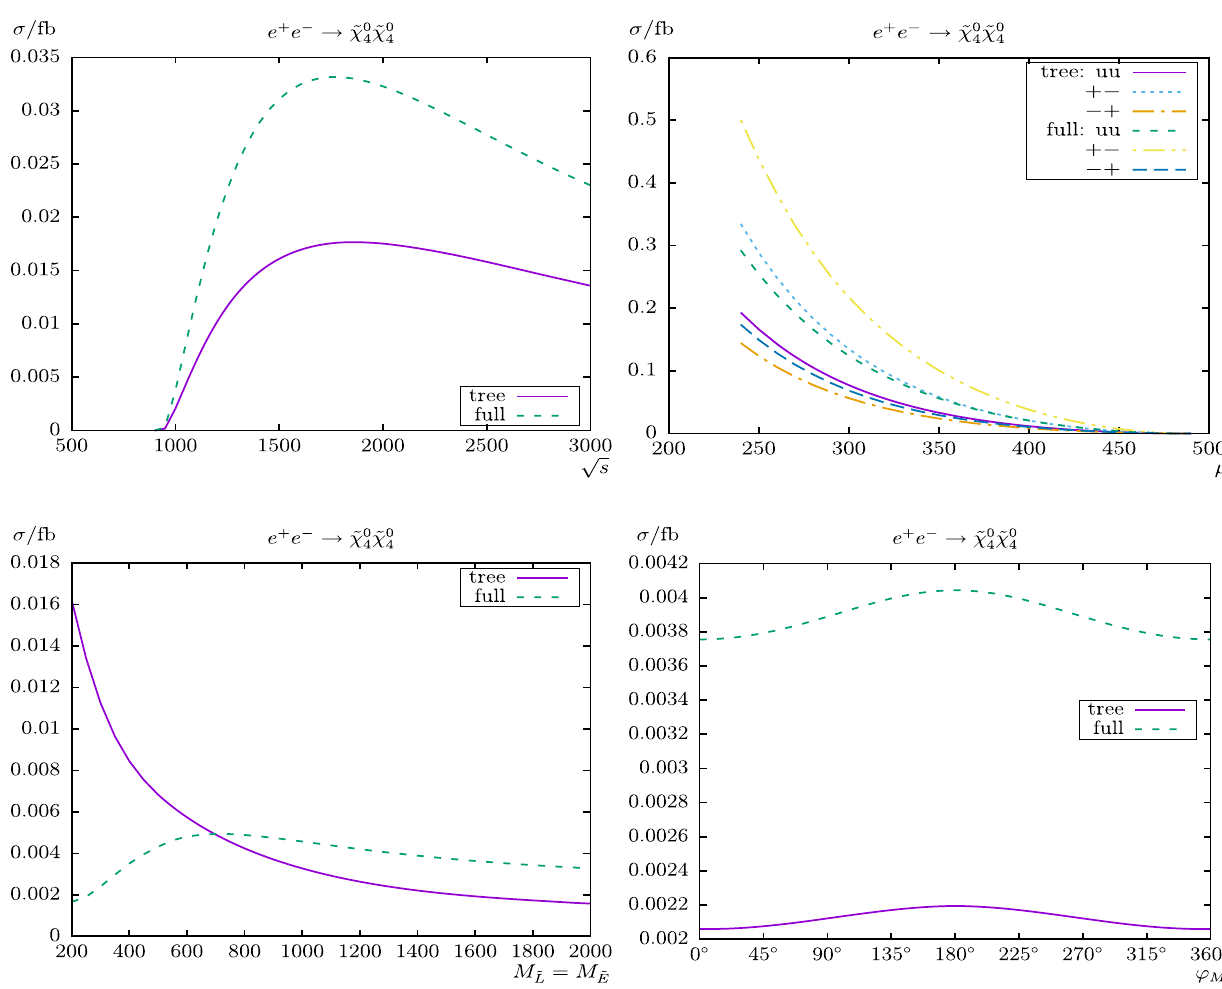
˜ χ 0 ) . Tree-level and full one-loop corrected 4 4